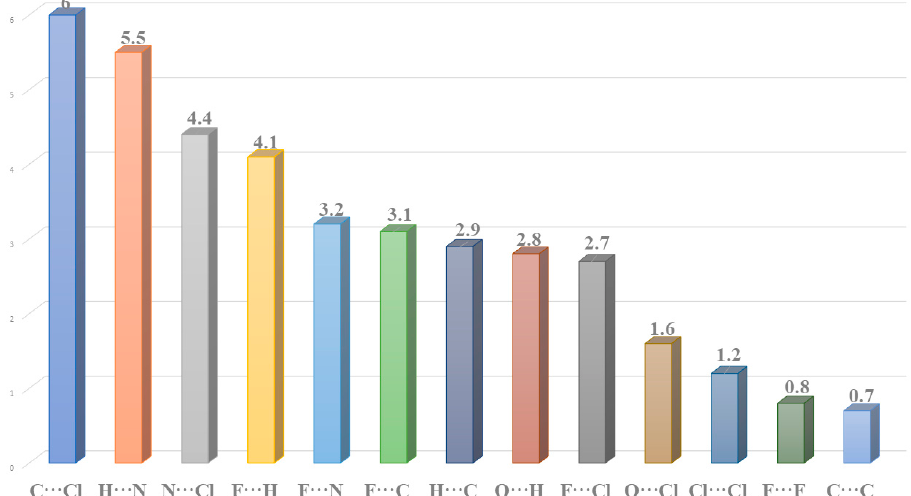
Figure 6. The relative contribution of intermolecular contacts in (H2Fluconazole).SnCl 6 .2H 2 O to the Hirshfeld surface. Table 3. Analysis of contacts on the Hirshfeld surface. The % of contact types (SX) between chemical species is given followed by random contacts (%) and their enrichment ratio (E). The major contacts as well as the major enriched ones are highlighted in bold characters.